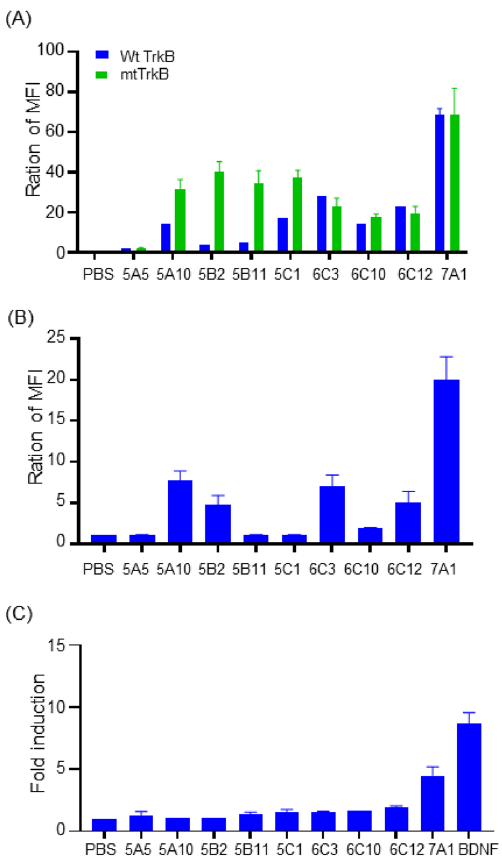
Figure 6. Validation of anti-mutated TrkB antibodies. ( A ) Comparison of cell binding with anti TrkB mutation antibodies (10 μg/mL) in wide-type TrkB (wtTrkB), and TrkB mutation (mtTrkB, N67S, V87D, R136H and D386N) stable cell lines by flow cytometry. ( B ) Determination of cell binding in breast cancer cell line MDA-MB-231 with anti-mtTrkB antibodies by flow cytometry. ( C ) TrkB-CRE-bla 293 reporter cell lines were treated with BDNF (100 ng/mL), anti TrkB mutation antibodies at 10 μg/mL or isotype antibody for 5 h. Cells were incubated with the CCF4-AM substrate and subjected to FACS based on the FRET signal. All data were repeated and normalized to the PBS control group. Abbreviation: Mean fluorescence intensity